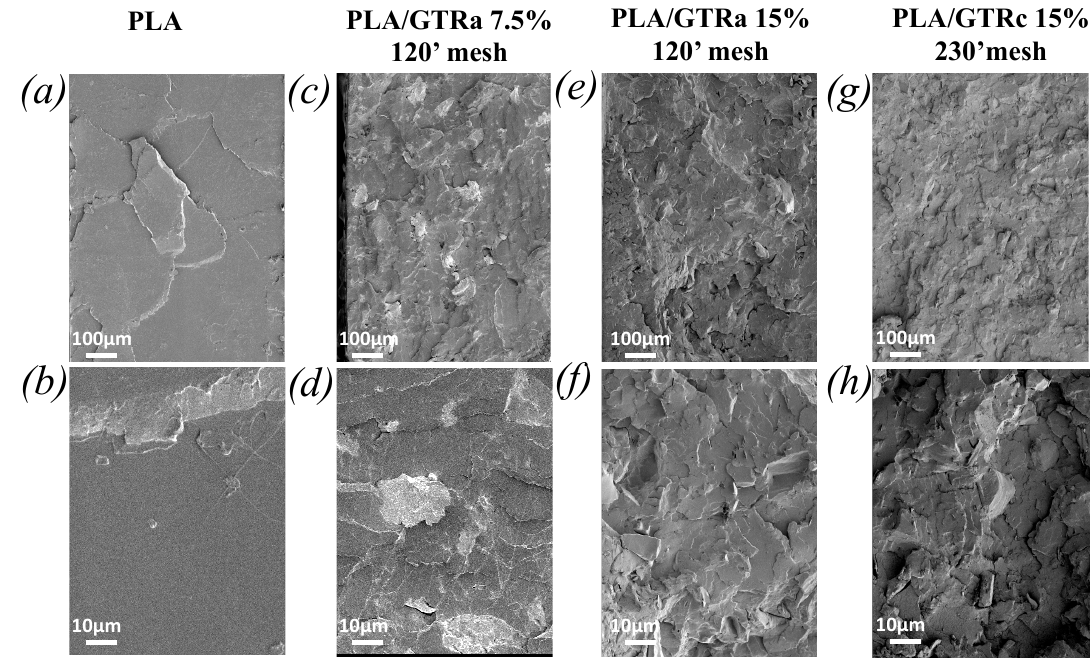
Figure 11. SEM images of fracture surface at two magnitudes x 100 (top) and x 1000 (bottom) of neat PLA ( a , b ), PLA/GTR a 7.5 wt% with DCP ( c , d ), PLA/GTR a 15 wt% with DCP ( e,f ), PLA/GTR c 15 wt% with DCP ( g , h ).